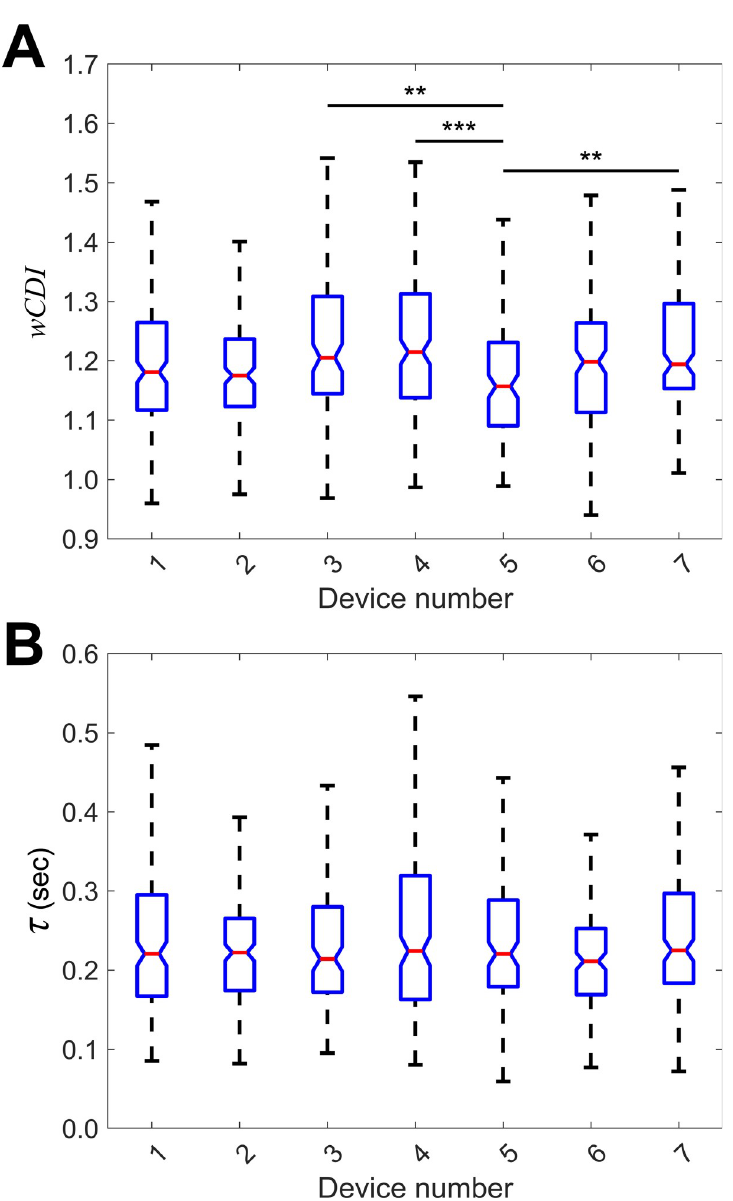
Fig 2. Between-device variability of mechanical phenotyping parameters measured by mechano-NPS. (A) Box plots of whole-cell deformability index ( wCDI ) for a single sample of AP-1060 cells analyzed using seven separate devices. Notches represent 95% confidence intervals for the true sample median for each distribution. �� indicates p < 0.01; ��� indicates p < 0.001. Statistical significance between devices was determined using pairwise Wilcoxon rank sum tests for unequal medians, where the critical value for multiple comparisons was calculated using a Tukey-Kramer method. ( p 3,5 = 0.0021, p 4,5 = 0.0007, p 5,7 = 0.0010; n 1 = 182, n 2 = 184, n 3 = 127, n 4 = 176, n 5 = 134, n 6 = 155, n 7 = 167). (B) Box plots of recovery time constant ( τ ) for the AP-1060 cells analyzed in (A) on each of seven devices. Notches represent 95% confidence intervals for the true sample median for each distribution. A Kruskal-Wallis test failed to reject the null hypothesis that the recovery time constants measured by each device came from the same distribution. ( n 1 = 182, n 2 = 184, n 3 = 127, n 4 = 176, n 5 = 134, n 6 = 155, n 7 =